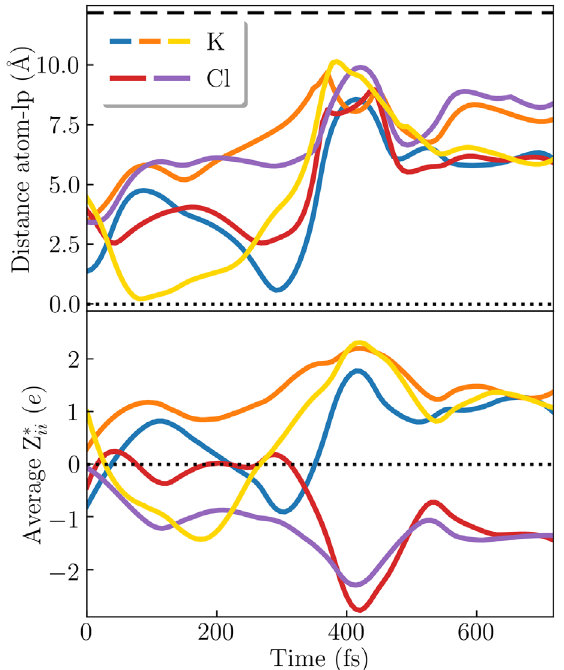
FIG. 7. Upper: Time series of the distances from the electron lone pair in K 33 Cl 31 of the five nearest atoms. The horizontal lines are guides for the eye: dotted, distance equal to zero; dashed, maximum distance allowed in PBCs, i.e., Average diagonal elements of the Born effective-charge tensor of the five atoms described above; the horizontal dotted line marks the zero